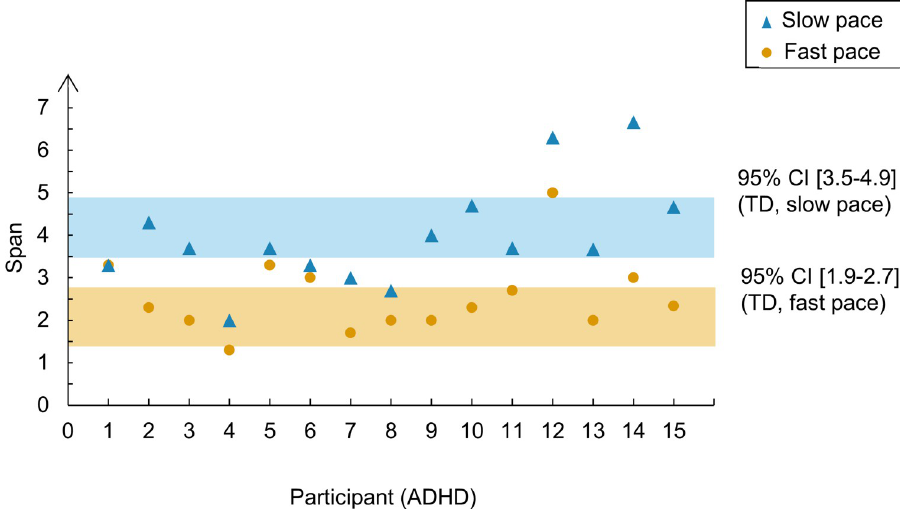
Fig 4. Individual spans in the ADHD group per pace condition in Experiment 1. Each data point in the graph represents an individual span in the ADHD group. The shaded zones represent the 95% confidence intervals of the mean in the control